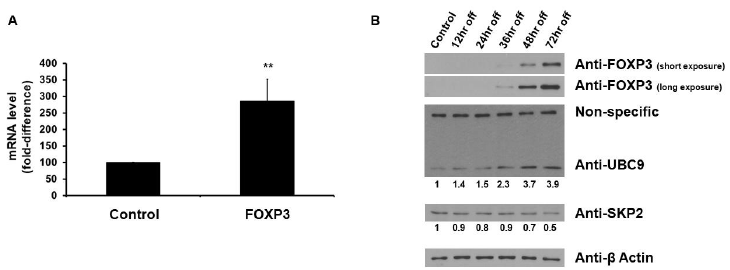
Figure 1. Forkhead Box Protein P3 (FOXP3) increases the UBC9 level. ( A ) Real-time RT-PCR analysis of UBC9 expression by FOXP3 from MCF7 human breast cancer cells. Total RNA was extracted and reverse transcribed to cDNA, followed by qPCR analysis with glyceraldehyde-3-phosphate dehydrogenase (GAPDH) as an internal control. Each point represents the average of three experiments, each with triplicate samples. Error bars indicate standard errors. ** indicates p < 0.001; ( B ) Western blot analysis of UBC9 expression from FOXP3-Tet-off MCF7 cells. The expression levels of FOXP3, UBC9, and SKP2 in FOXP3-Tet-off MCF7 cells were determined using anti-FOXP3, anti-UBC9, and anti-SKP2 immunoblotting, respectively. The β -Actin levels were also determined for equal